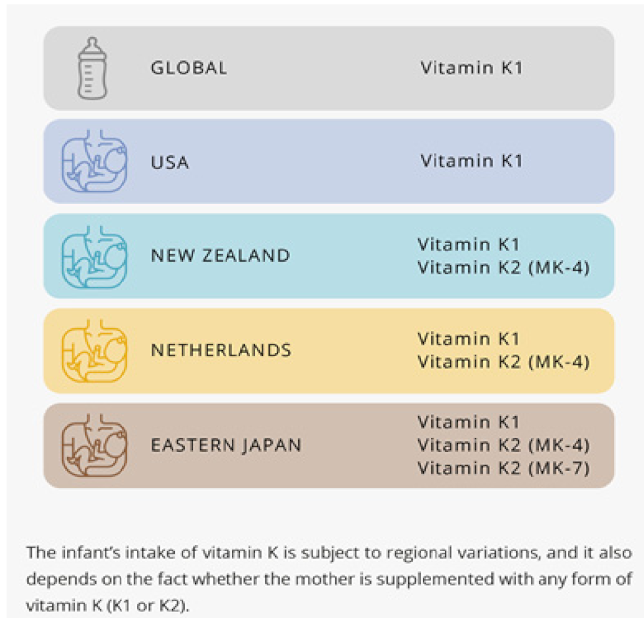
Figure 3. Presence of K1 and K2 from formula vs. breastmilk (regional